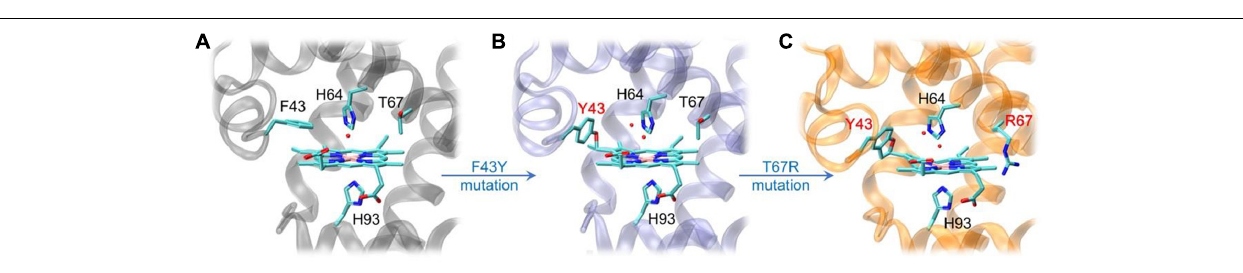
FIGURE 2 | X-ray crystal structures of wild-type (WT) Mb [ A , PDB code 1JP6 (Urayama et al., 2002)], F43Y Mb [ B , PDB code 4QAU (Yan et al., 2015)], and F43Y/T67R Mb [ C , PDB code 6JP1 (Liu et al., 2019)], respectively, showing the heme active site and Tyr-heme